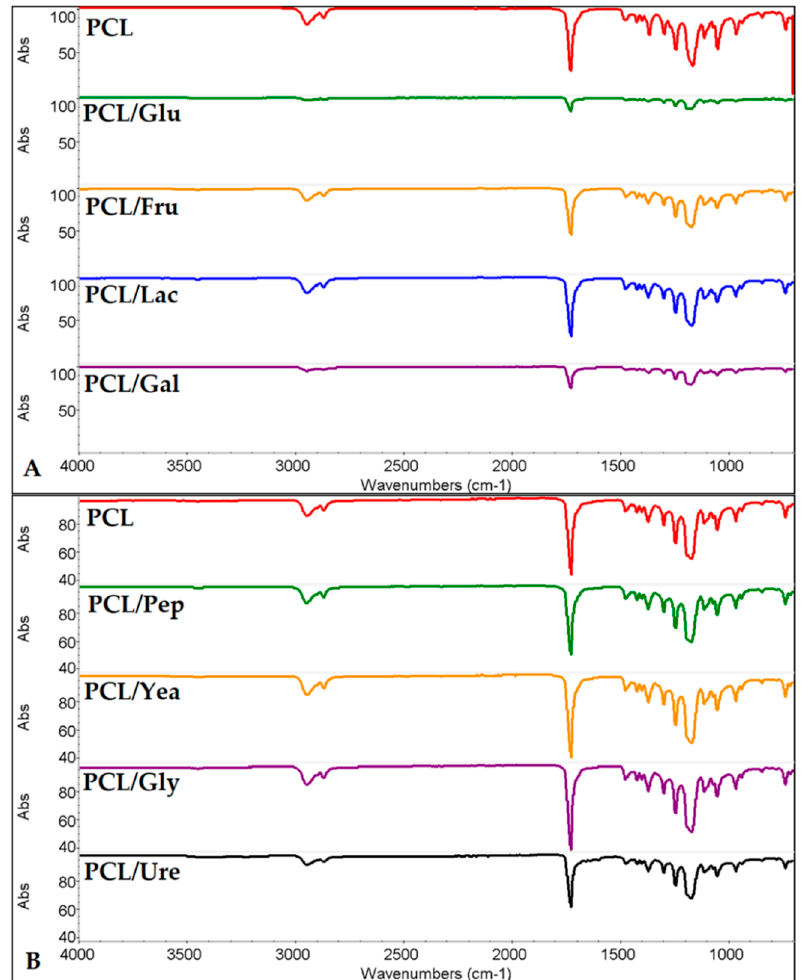
Figure 1. Infrared spectrum of PCL with ( A ) PCL/Cs fibers ( B ) PCL/Ns fibers.